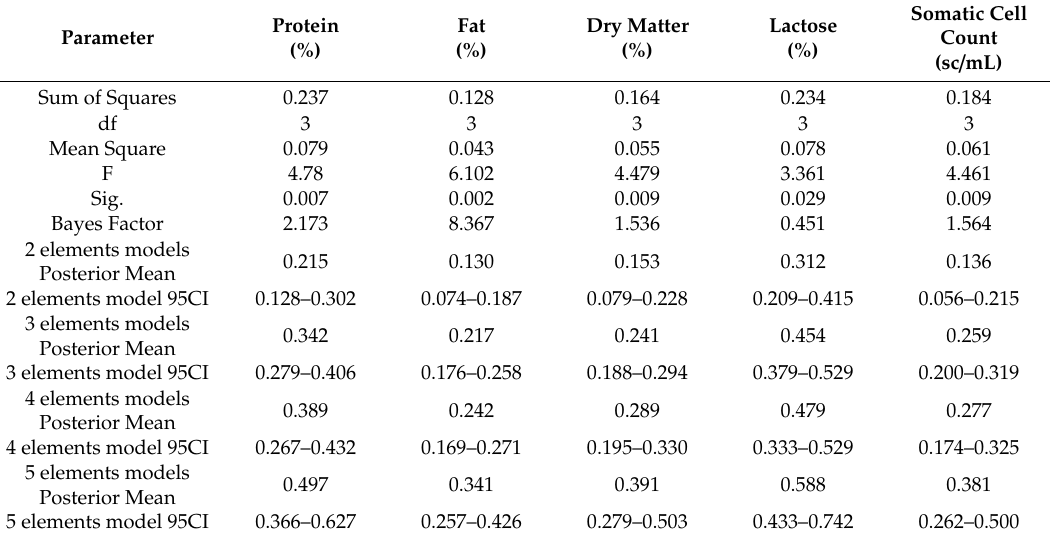
Table 2. Summary of the Bayesian ANOVA to test for di ff erences in the mean for the adjusted R 2 across models comprising two, three, four, or five